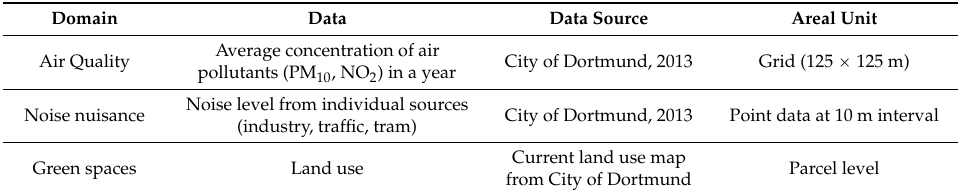
Table 2. Data characteristics and sources for environmental